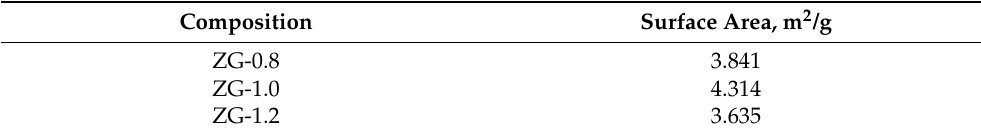
Table 7. The specific surface area of zeolite